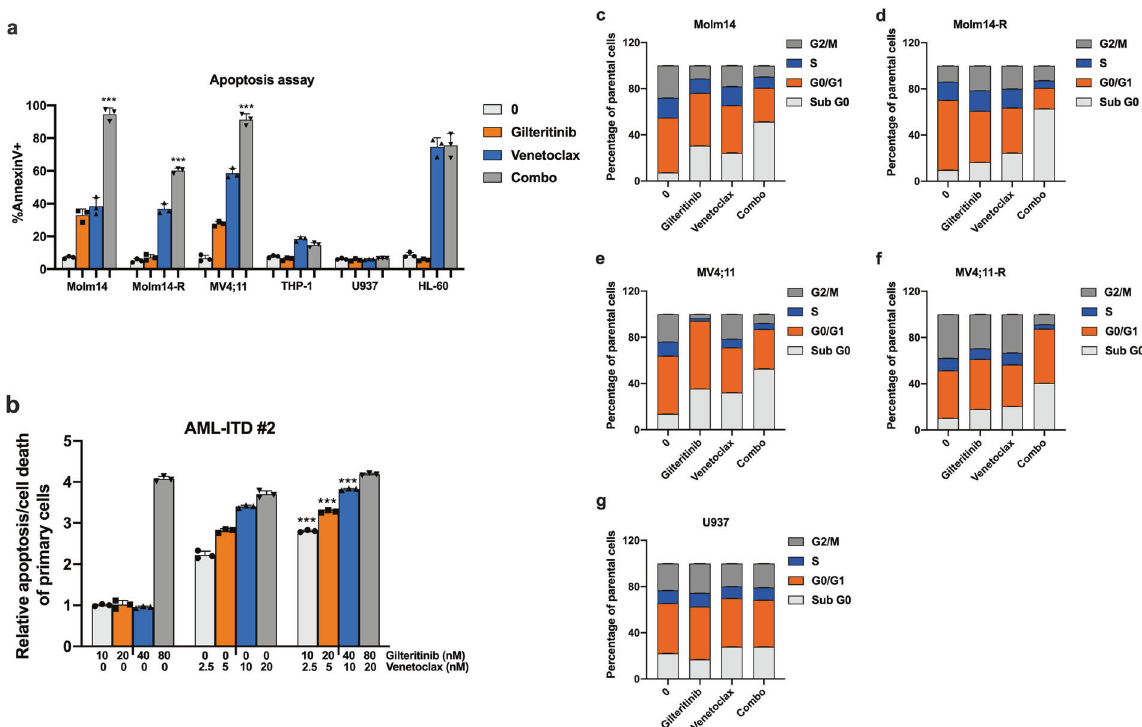
graph of 48 h apoptosis/cell death assay of primary FLT3/ITD AML patient sample #2 treated with the indicated concentration of Gilteritinib and Venetoclax. c – g Bar graphs of cell cycle analysis of Molm14, Molm14-R, MV4;11, MV4;11-R, and U937 treated